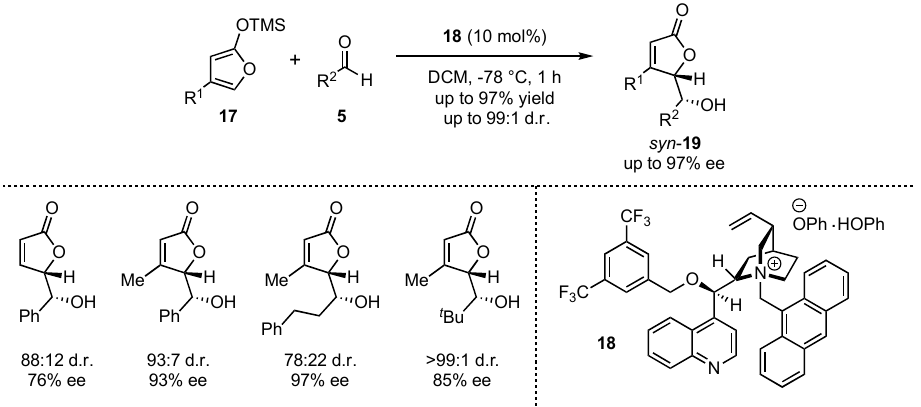
Scheme 4. Asymmetric organocatalyzed VMAR reaction between Chan’s diene and electron-rich and poor aldehydes by Scettri et al. [30,33].